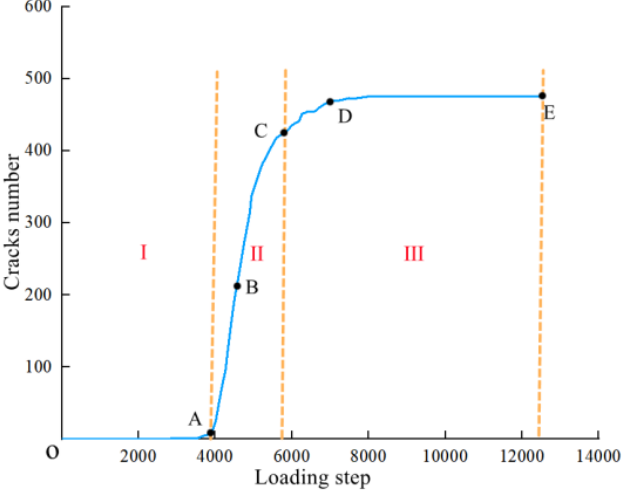
Figure 13. Cracks number curve.